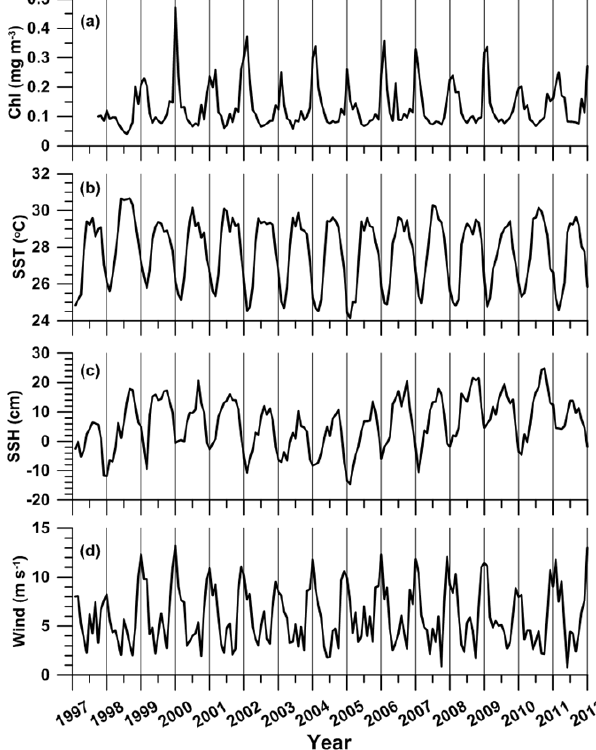
Fig. 7. Non-seasonal variations (anomalies) of monthly mean values of environmental variables within the study area and the multivari- ate ENSO index (MEI): (a) sea surface chlorophyll- a concentration; (b) sea surface temperature; (c) sea surface height; (d) wind speed at 10m above sea level; and (e) MEI. The ENSO events are marked as colour stripes: El Niño events in yellow and La Niña in